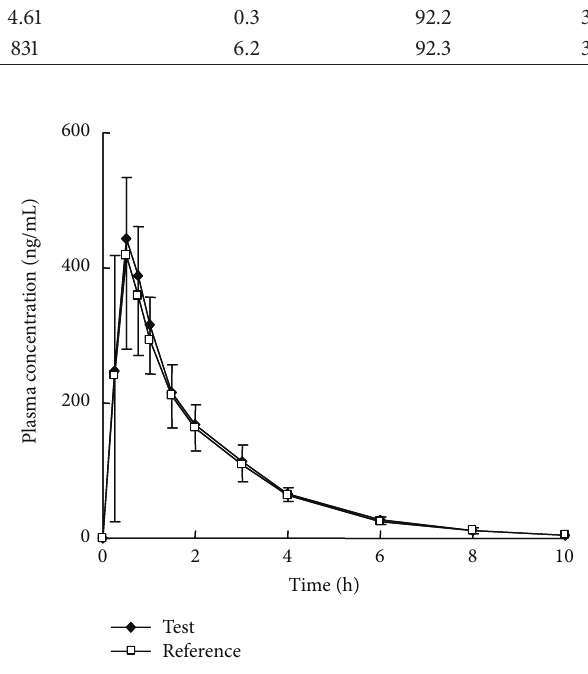
Figure 3: Mean plasma concentration versus time curve of stavu- dine after oral administration of 20 mg stavudine capsule test and reference formulations to 18 healthy volunteers (𝑛 = 20, 𝑥 ± 𝑠)